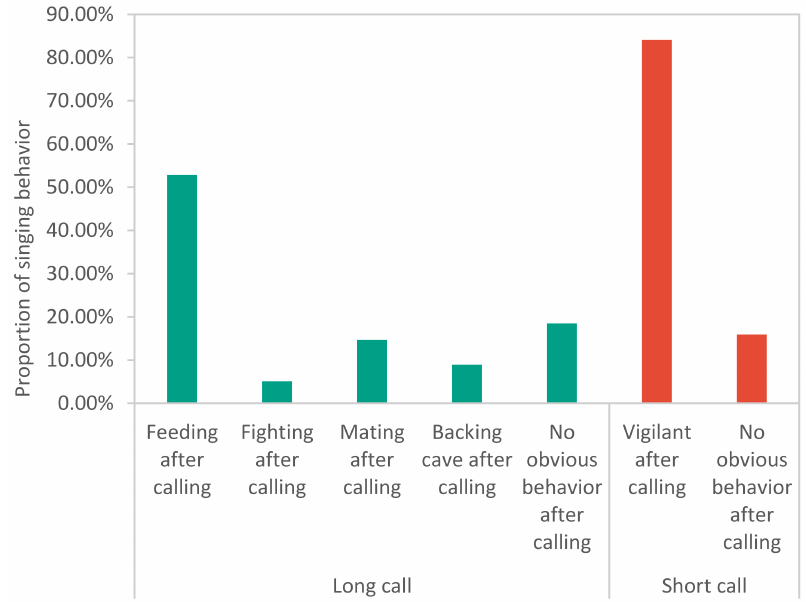
Figure 4. For long calls, feeding, fighting, mating, retreating to the burrow and no obvious behavior after calling accounted for a relatively high proportion, whereas vigilance after calling accounted for a high proportion for short calls. Through further statistical testing ( p < 0.05), it was found that there were significant differences between long and short calls in terms of the different behaviors after